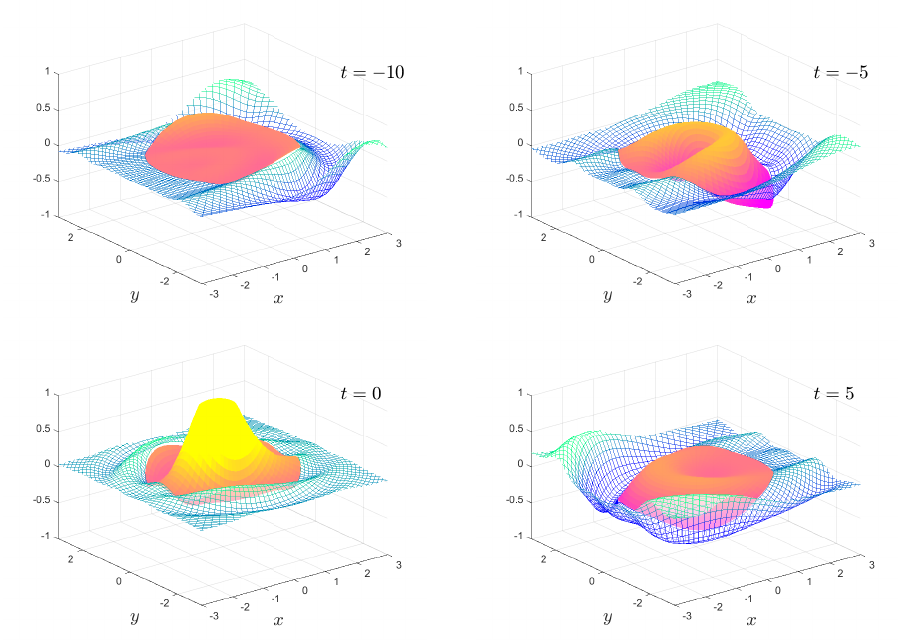
Figure 9. As in Figure 6, except β = 1 × 10 − 2 . The full animation can be found in movie